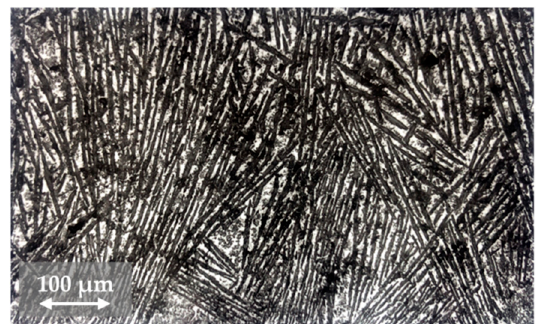
Figure 7. Final structure of the slag collected after termination of oxygen blowing, in the melting process D, sample D27.